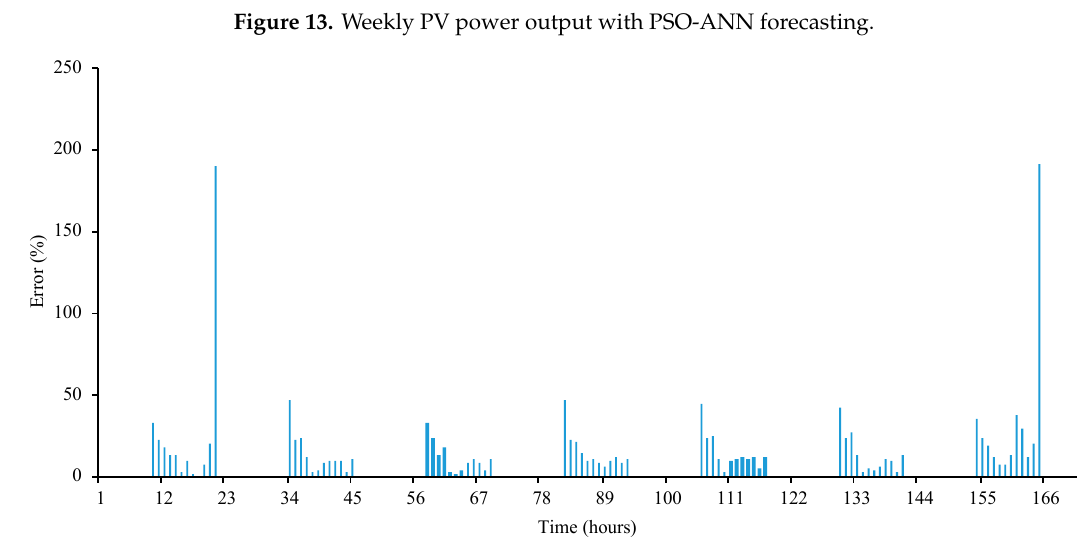
Figure 14. Weekly PV power output percentage error with PSO-ANN forecasting.